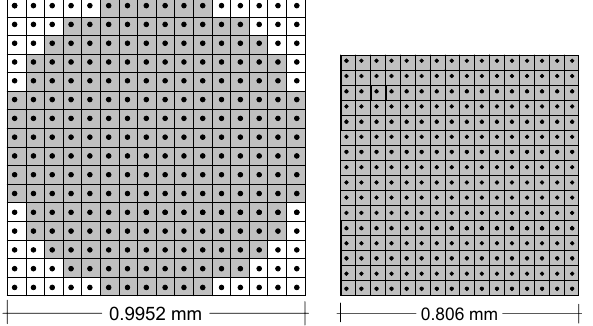
Fig. 1. Dipole assignment for the modeled ice sphere and ice cube (2-D projection). Assigned dipoles are gray and void dipoles are white. For the sphere 2176 dipoles and for the cube 4096 dipoles were assigned. The volume of both objects is that of a geometric sphere with 1mm in diameter, namely 0.524mm 3 .